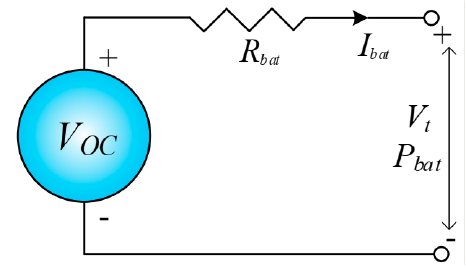
Figure 4. Battery equivalent circuit